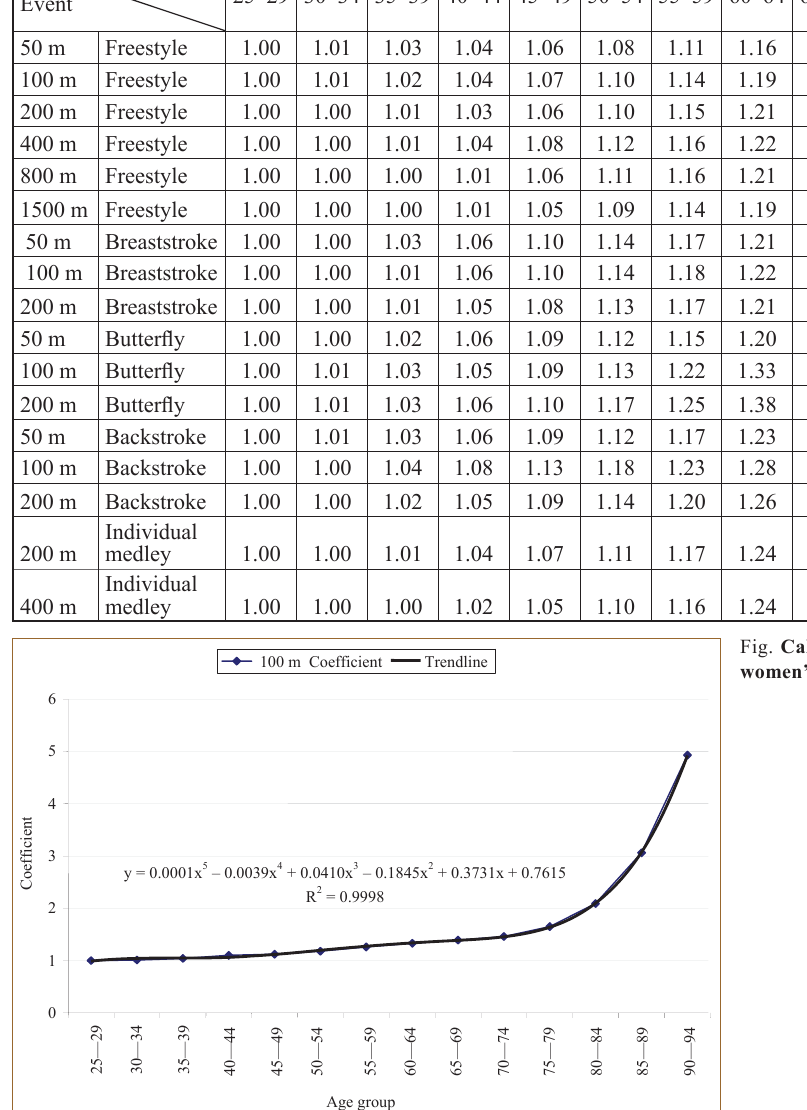
Table 4. Coef fi cients for indexing masters’ swimming times (men )